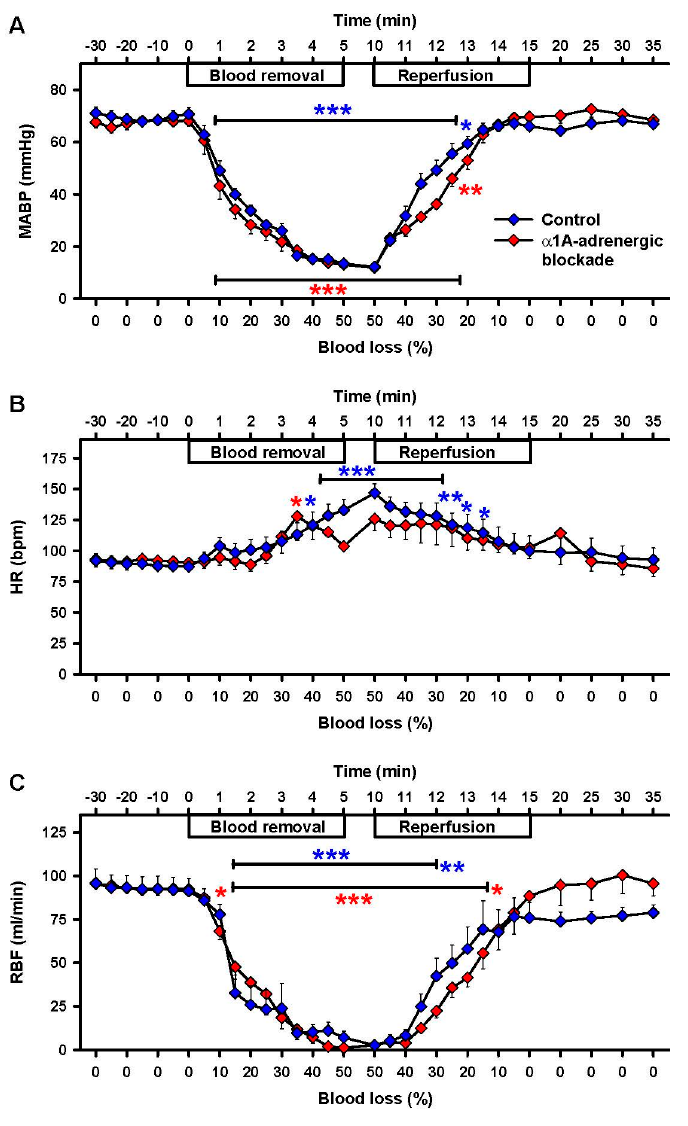
Figure 2. Effects of 50% blood loss and reperfusion on vital parameters. ( A ) Mean arterial blood pressure (MABP), ( B ) heart rate (HR) and ( C ) renal blood flow (RBF). Controls in blue and α 1A-adrenergic blockade in red. Mean ± SEM; * p < 0.05, ** p < 0.01 and *** p < 0.001 compared to baseline.